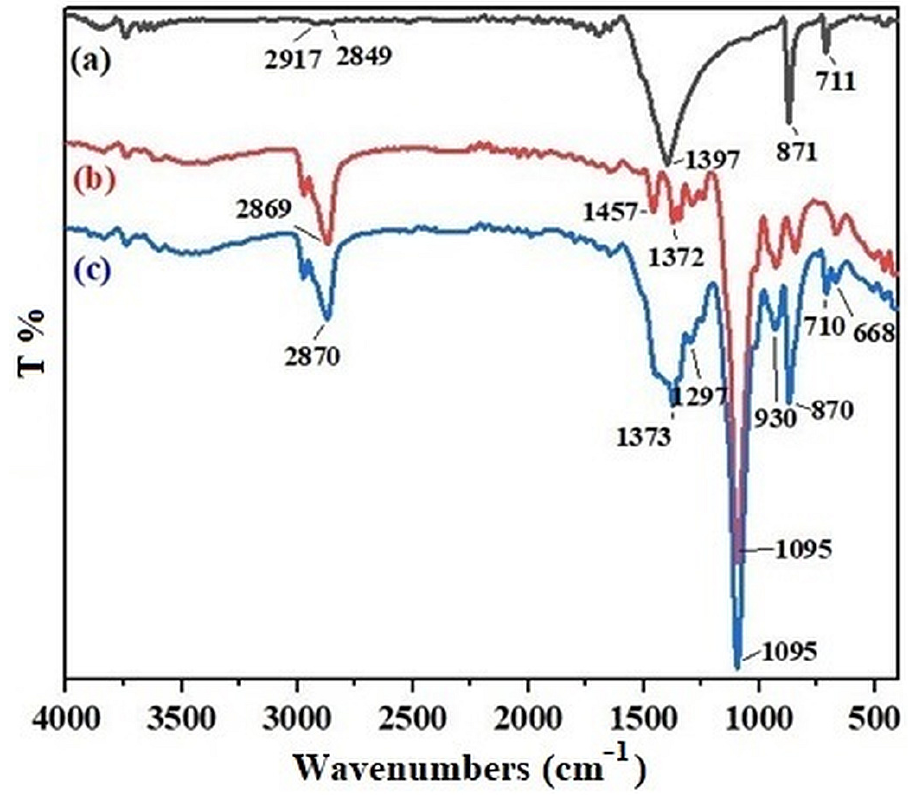
Figure 1. Comparative FT-IR spectra of ( a ) calcite, ( b ) Pluronic ® P-123, and ( c ) m Calcite.